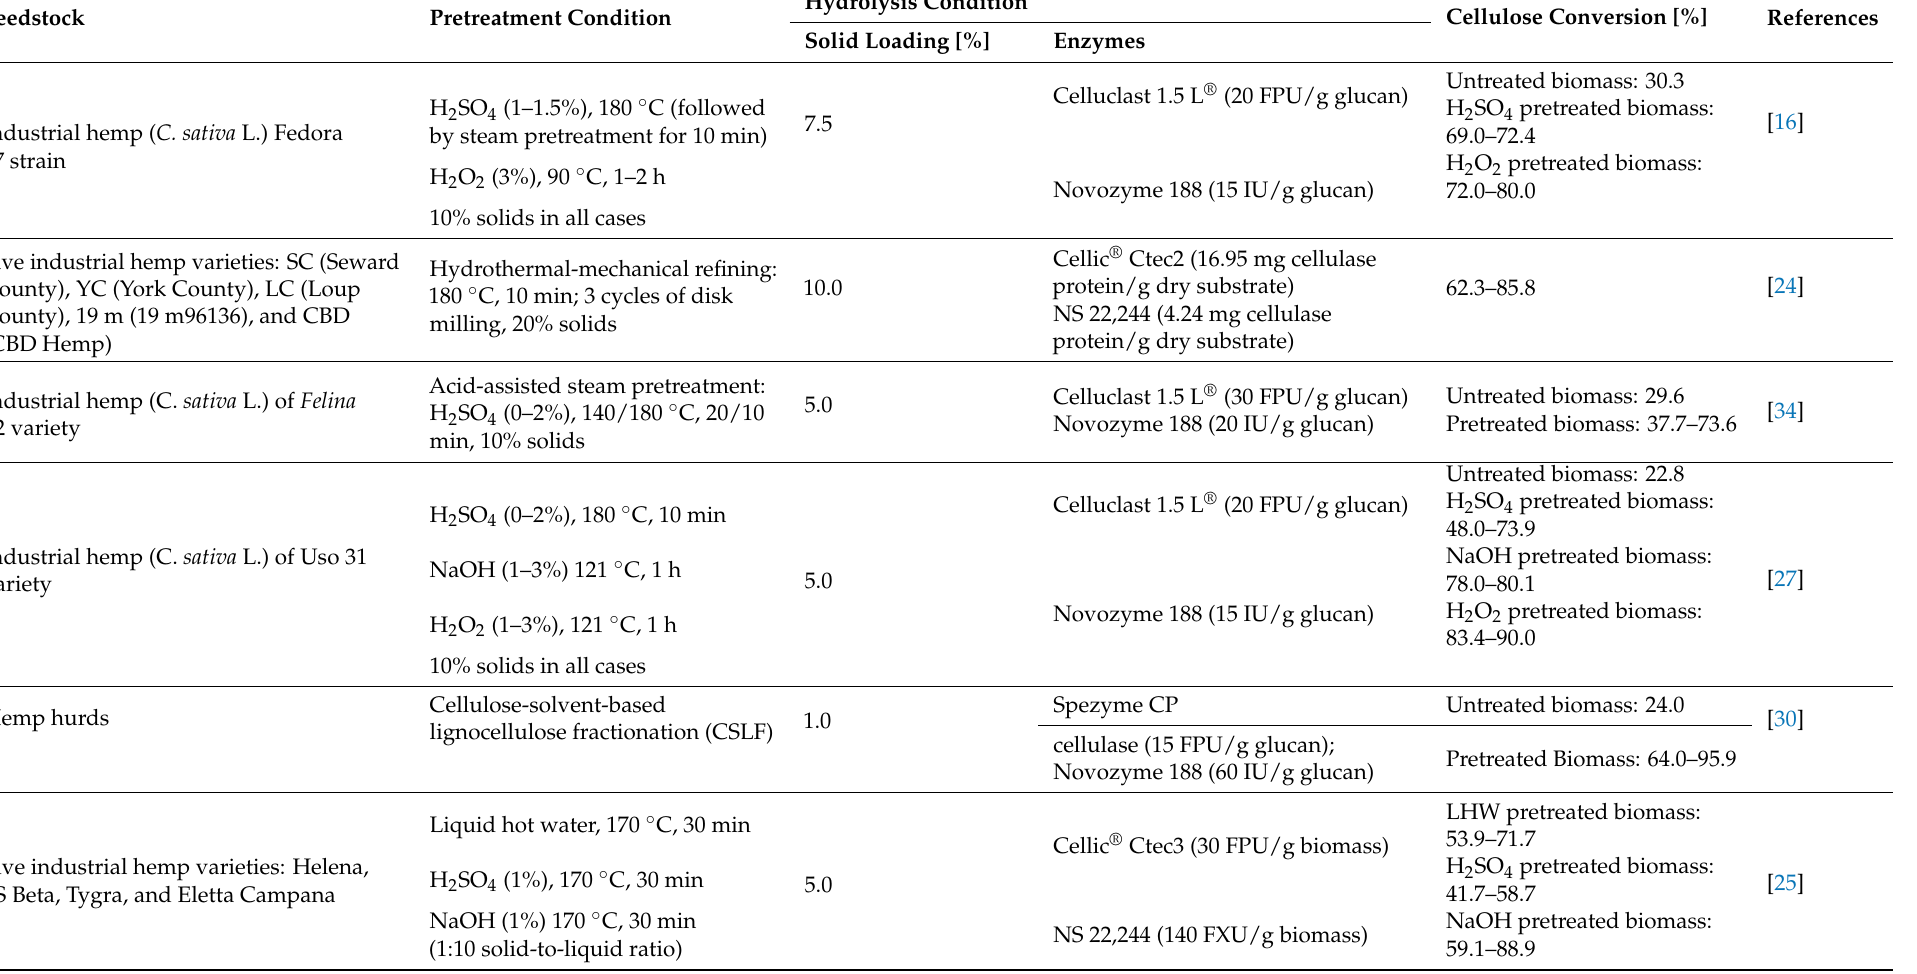
Table 3. Effect of pretreatment on cellulose conversion during enzymatic